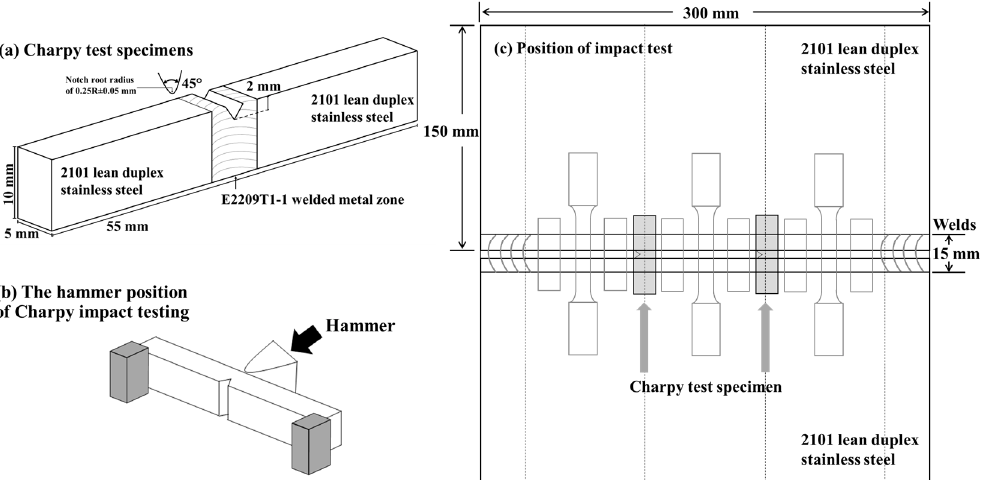
Figure 8. Schematic showing the Charpy v-notch impact testing process: ( a ) the test specimens; ( b ) the hammer position; ( c ) the specimen’s position for impact tests.